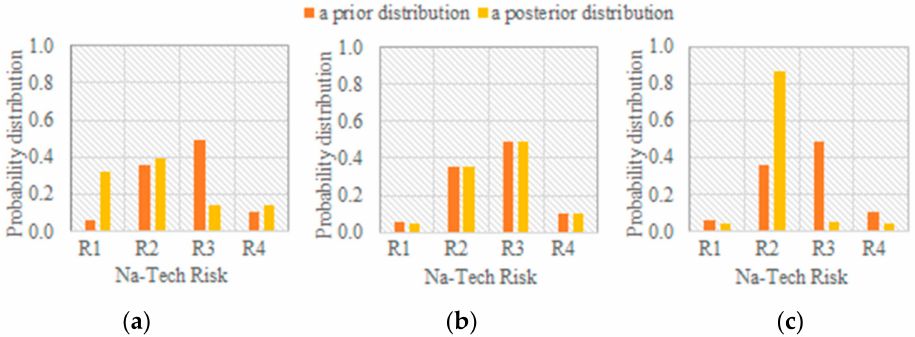
Figure 10. Distributions obtained for the target node from the adoption of: ( a ) measure 1; ( b ) mea- sure 2; and ( c ) measure